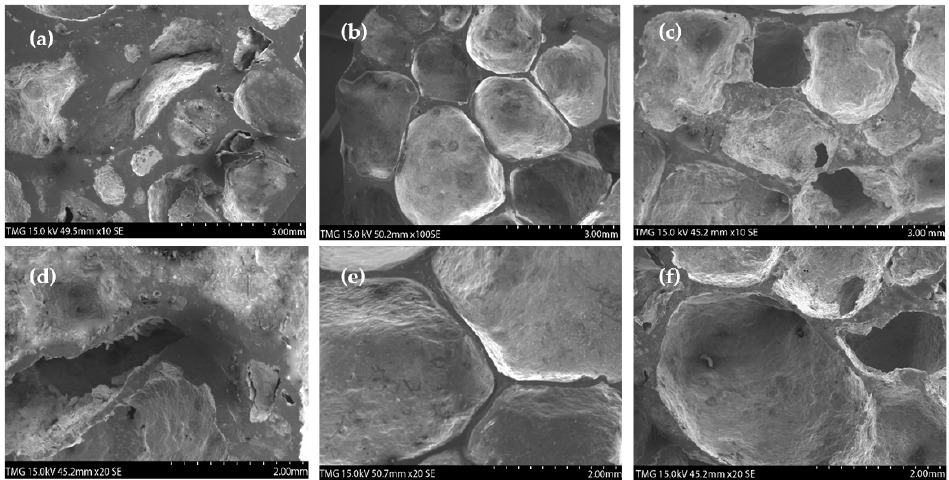
Figure 9. Pore morphologies of Al–10Ni with 5 wt.% dolomite ( a , d ), 7 wt.% dolomite ( b , e ), and 10 wt.% dolomite ( c , f ).